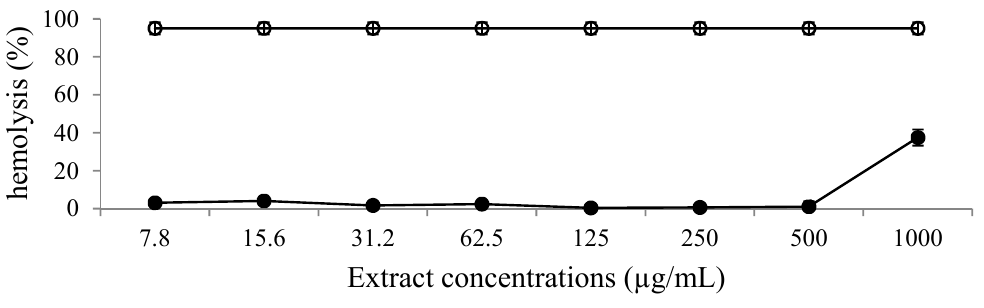
Figure 6. Hemolytic activity of luteolin. Luteolin (filled circle) and positive control Triton X-100 (open